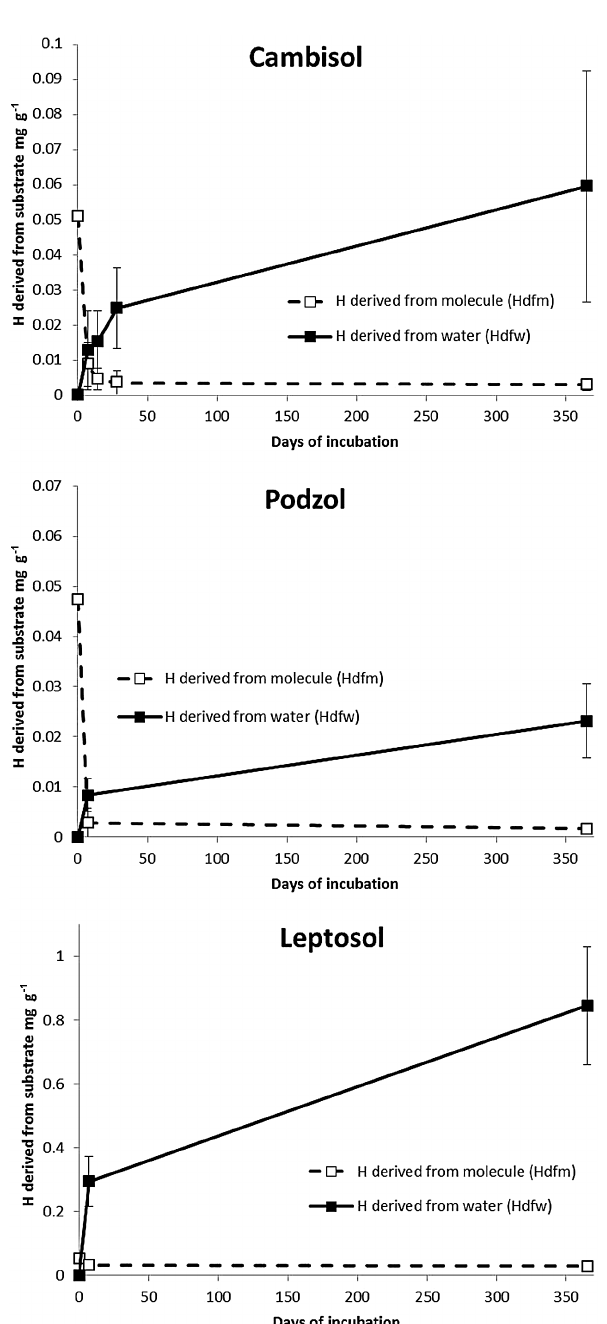
Figure 2. Concentration of water-derived (H dfw ) and molecule- derived (H dfm ) non-exchangeable hydrogen in the total soil for Cambisol, Podzol and mollic Leptosol from 0 to 365 days. The line corresponds to the mean value calculated at each time for all molecule experiments. Note that the scale of y axis is different for the three